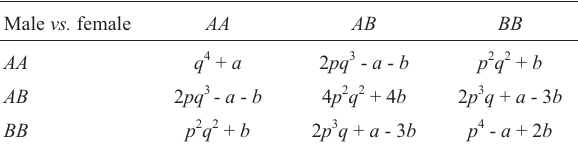
Table 1 - Li’s symmetric non-random mating model. Male vs.